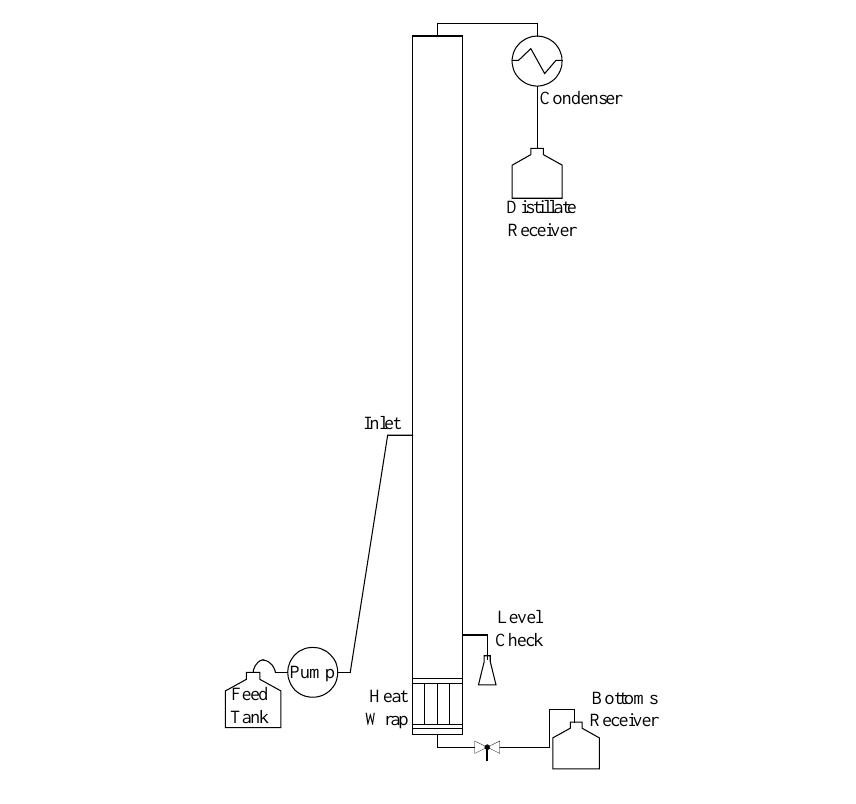
Figure 3. Schematic of the UND bench-scale continuous crackate distillation